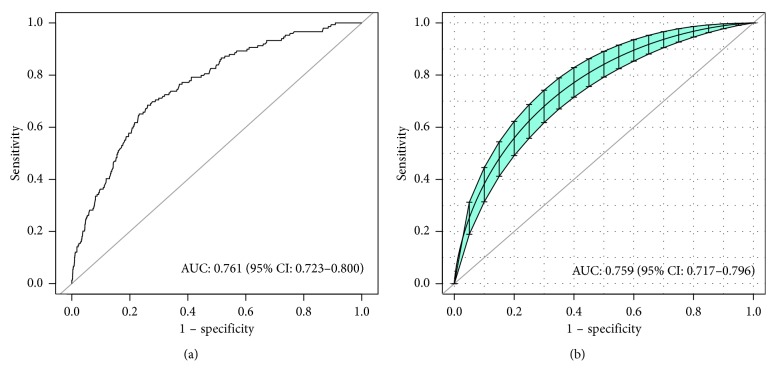
The receiver operating characteristic of the model and in the internal validation cohort. (a) AUC of the predictive model (representative the discriminatory ability of the model) and (b) AUC of the internal validation (bootstrap resampling = 500). The dotted vertical lines represent 95% confidence interval. AUC, area under the curve.